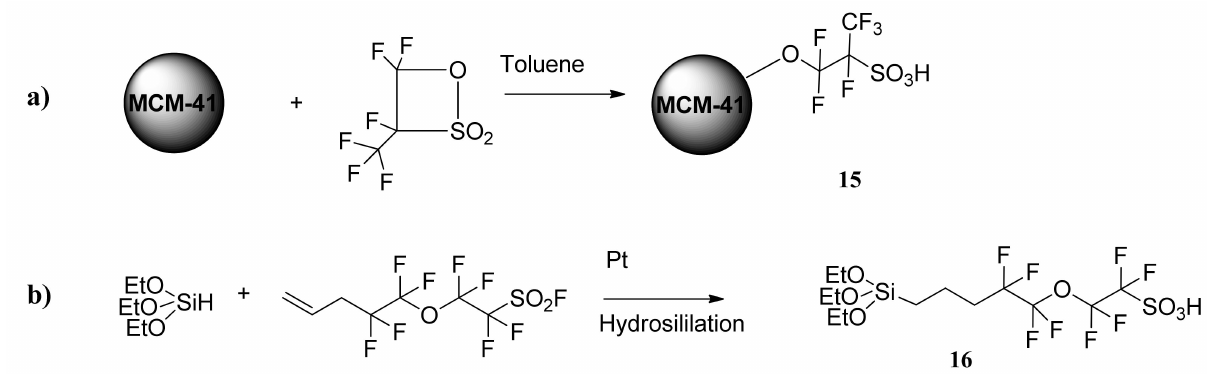
Figure 6. Fluoro derivatives sulfonic materials. ( a ) synthesis of sulfonic MCM-41 based on ref. [29]; ( b ) fluoro-based linker synthesized by Harmer et al.